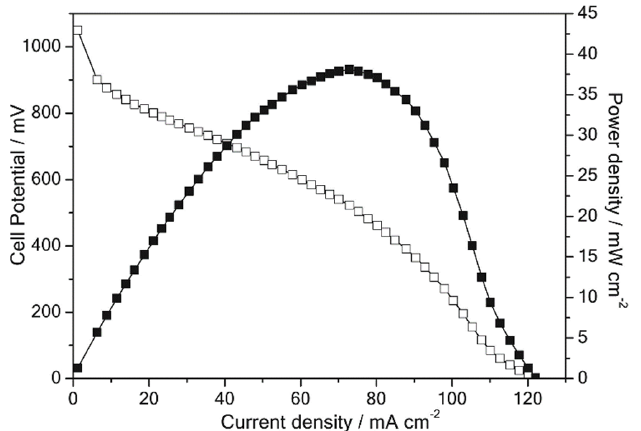
Figure 4. Single cell performance of CS/PAADDA/PUB (1:0.5:0.5) membrane in an H 2 /O 2 fuel cell at 25 °C. Reprinted with permission from Ref. [25]. Copyright 2020 John Wiley and Sons.